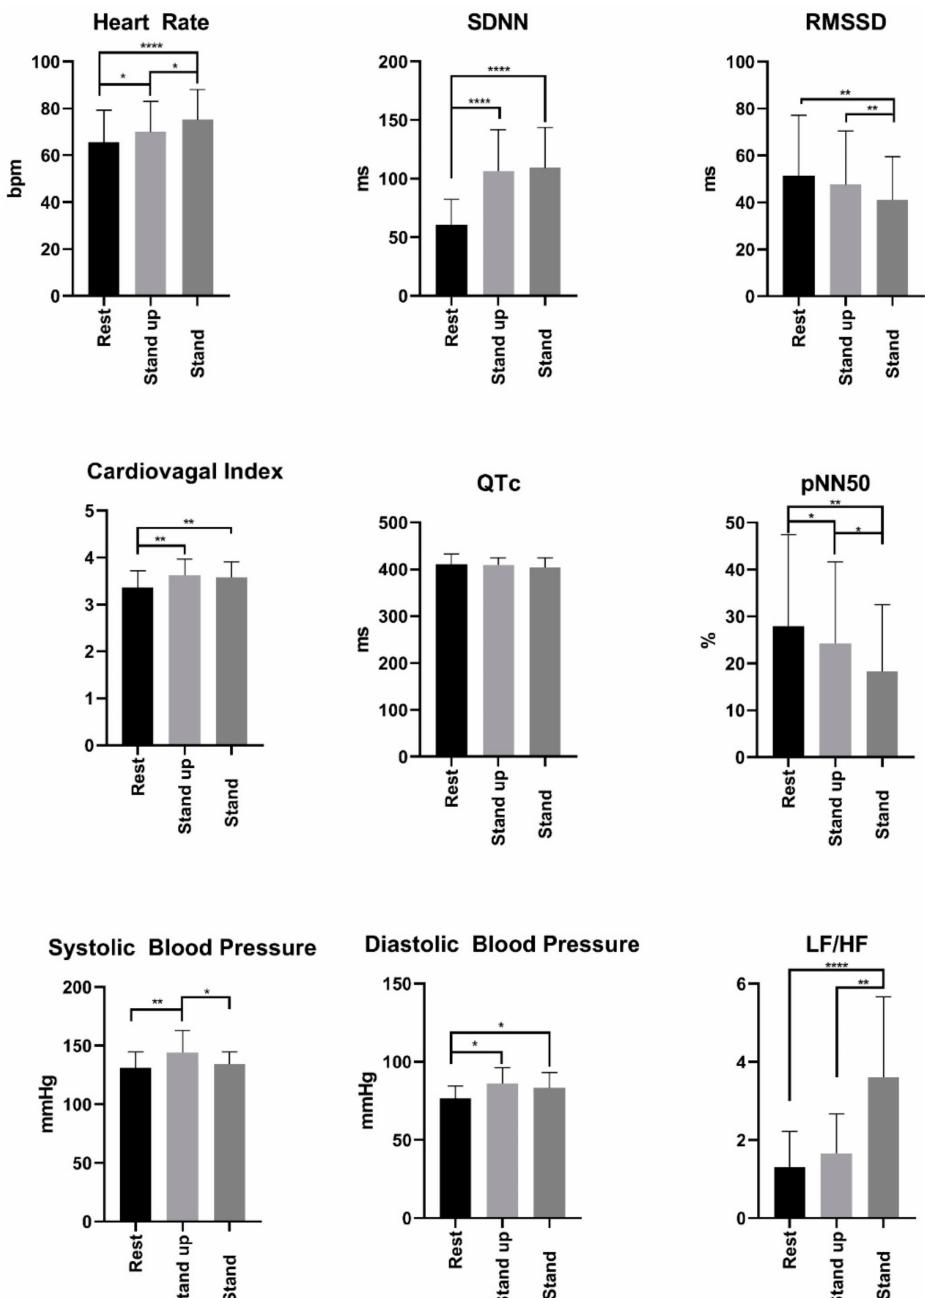
Figure 1. HRV detected during Schellong-1 at rest. Stars indicate level of significance. * indicates p < 0.05; ** indicates p < 0.01; **** indicates p < 0.0001; SDNN: standard deviation of adjacent NN intervals; RMSSD: root mean square of adjacent NN intervals; QTc: corrected QT time; pNN50: percentage of NN pairs that deviate by more than 50 ms; LF/HF: ratio between low frequency and high